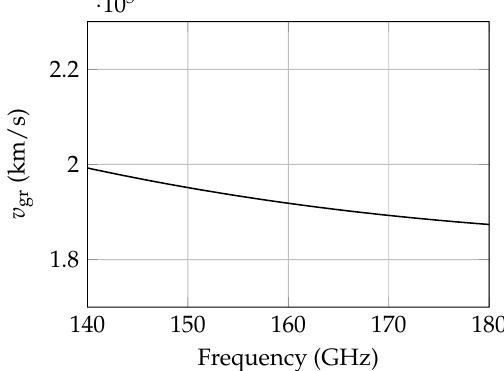
Figure 2. E-field distribution of the fundamental HE 11 mode in a dielectric waveguide with polarization in y -direction [12] ( c IEEE 2017). (cid:13)